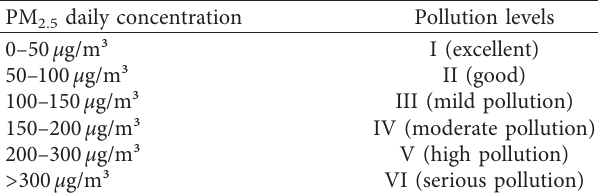
Table 1: PM 2.5 pollution